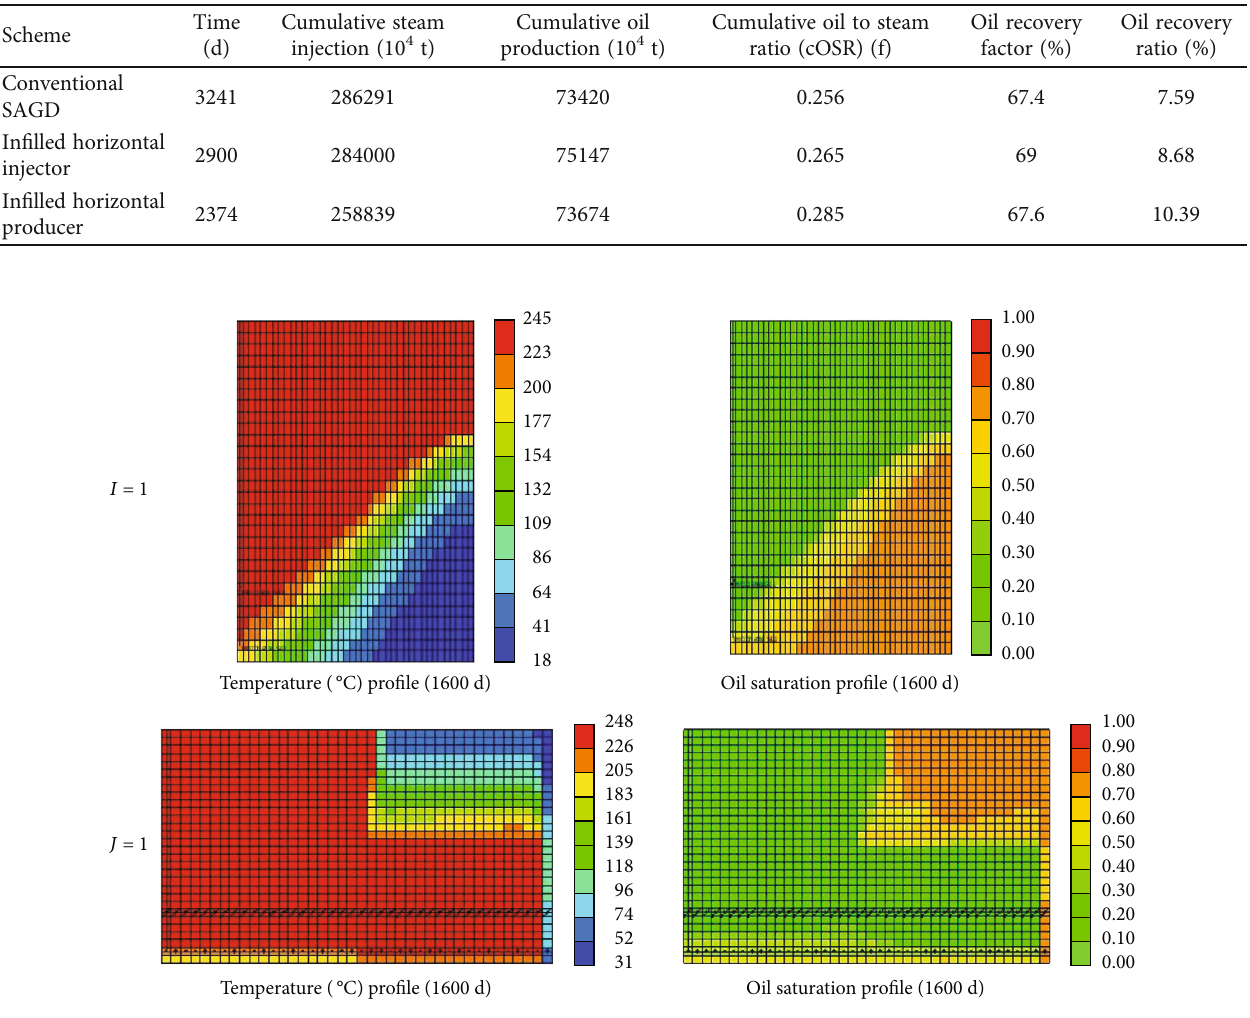
Figure 7: Temperature pro fi le and oil saturation pro fi le of model B.